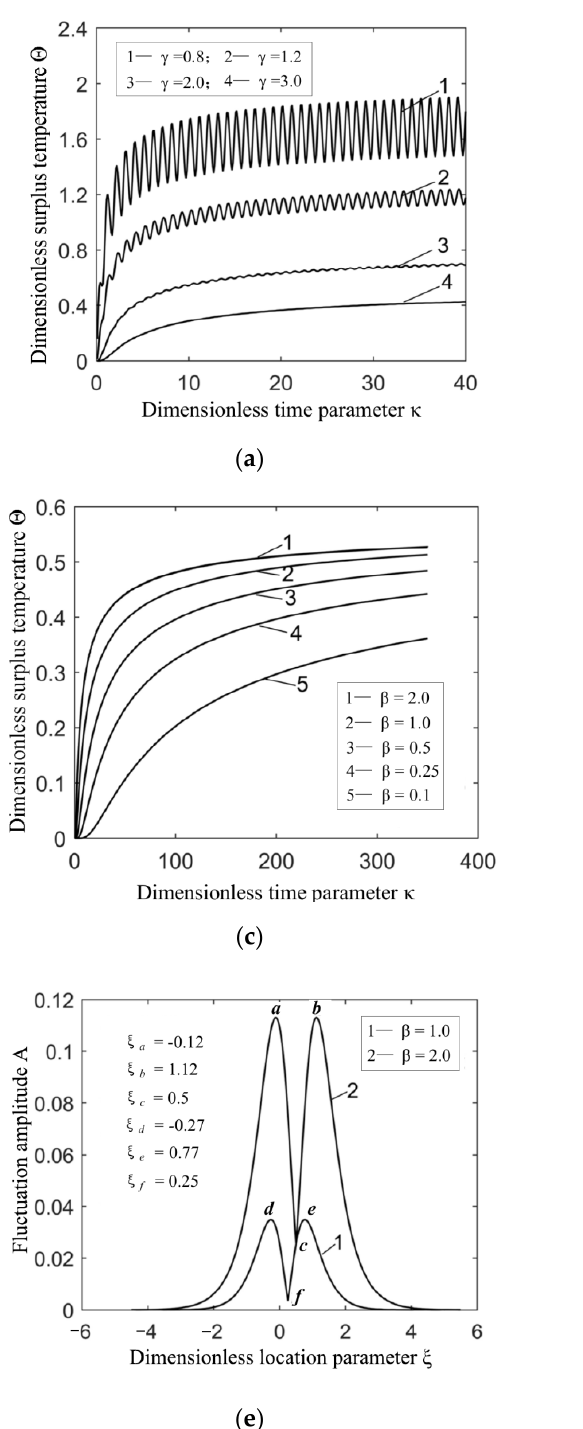
Figure 3. Graphical exhibition of numerical results with various dimensionless parameter values: ( a ) Dimensionless surplus temperature profiles over time parameter for various values of γ with fixed ξ = 0 and β = 2; ( b ) Fluctuation amplitude profiles over heat conduction parameter for various values of γ with fixed ξ = 0; ( c ) Dimensionless surplus temperature profiles over time parameter for various values of β with fixed ξ = 0 and γ = 2; ( d ) Dimensionless surplus temperature profiles over location parameter for various values of κ with fixed β = 2 and γ = 1; ( e ) Fluctuation amplitude profiles over location parameter for various values of β with fixed γ = 1.